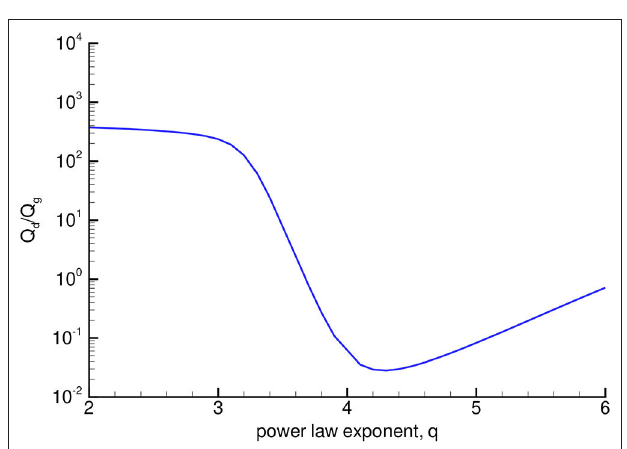
FIGURE 4 | Dust-to-gas mass production rate ratio vs. power-law exponent for constant dust brightness.